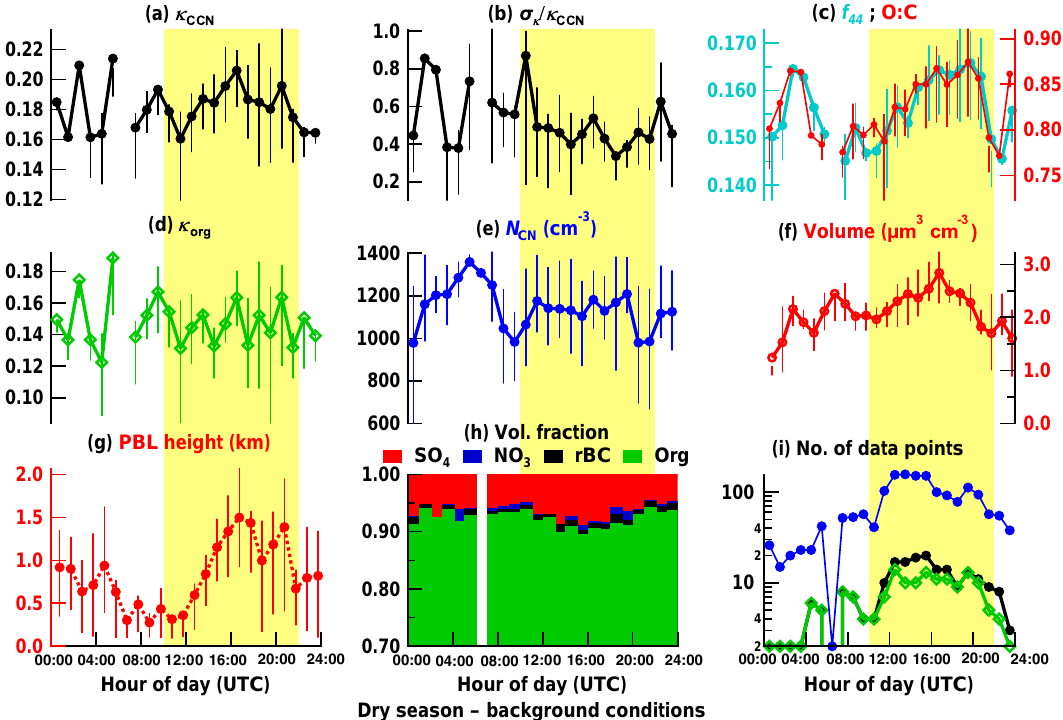
Figure 5. Diel variations of aerosol properties and meteorological parameters under background conditions during the dry season (analogous to Fig.